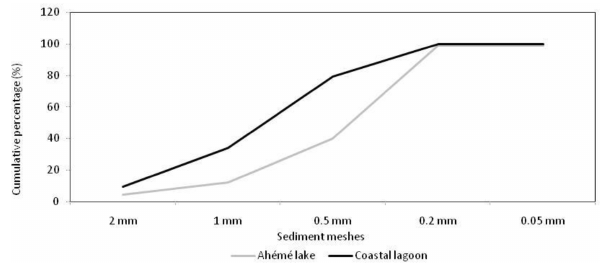
Figure 4. Sediment granulometric curves in the coastal lagoon and Ahémé lake (Source: Amoussou et al.,